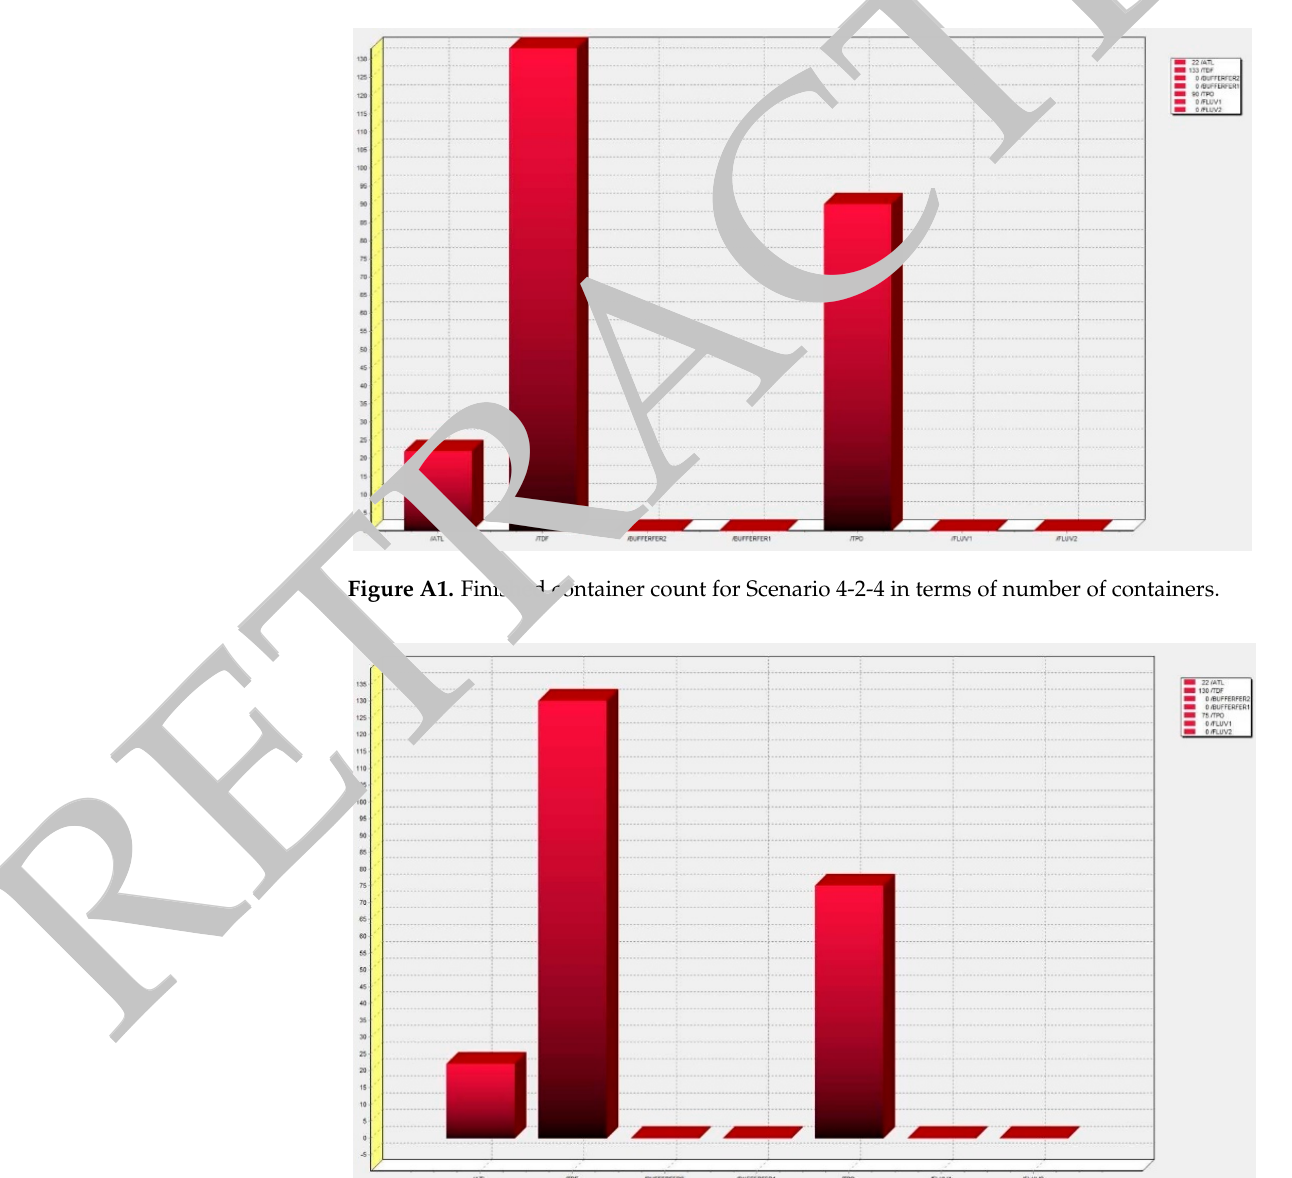
Figure A2. Number of containers at the end of the day for Scenario 5-2-5.